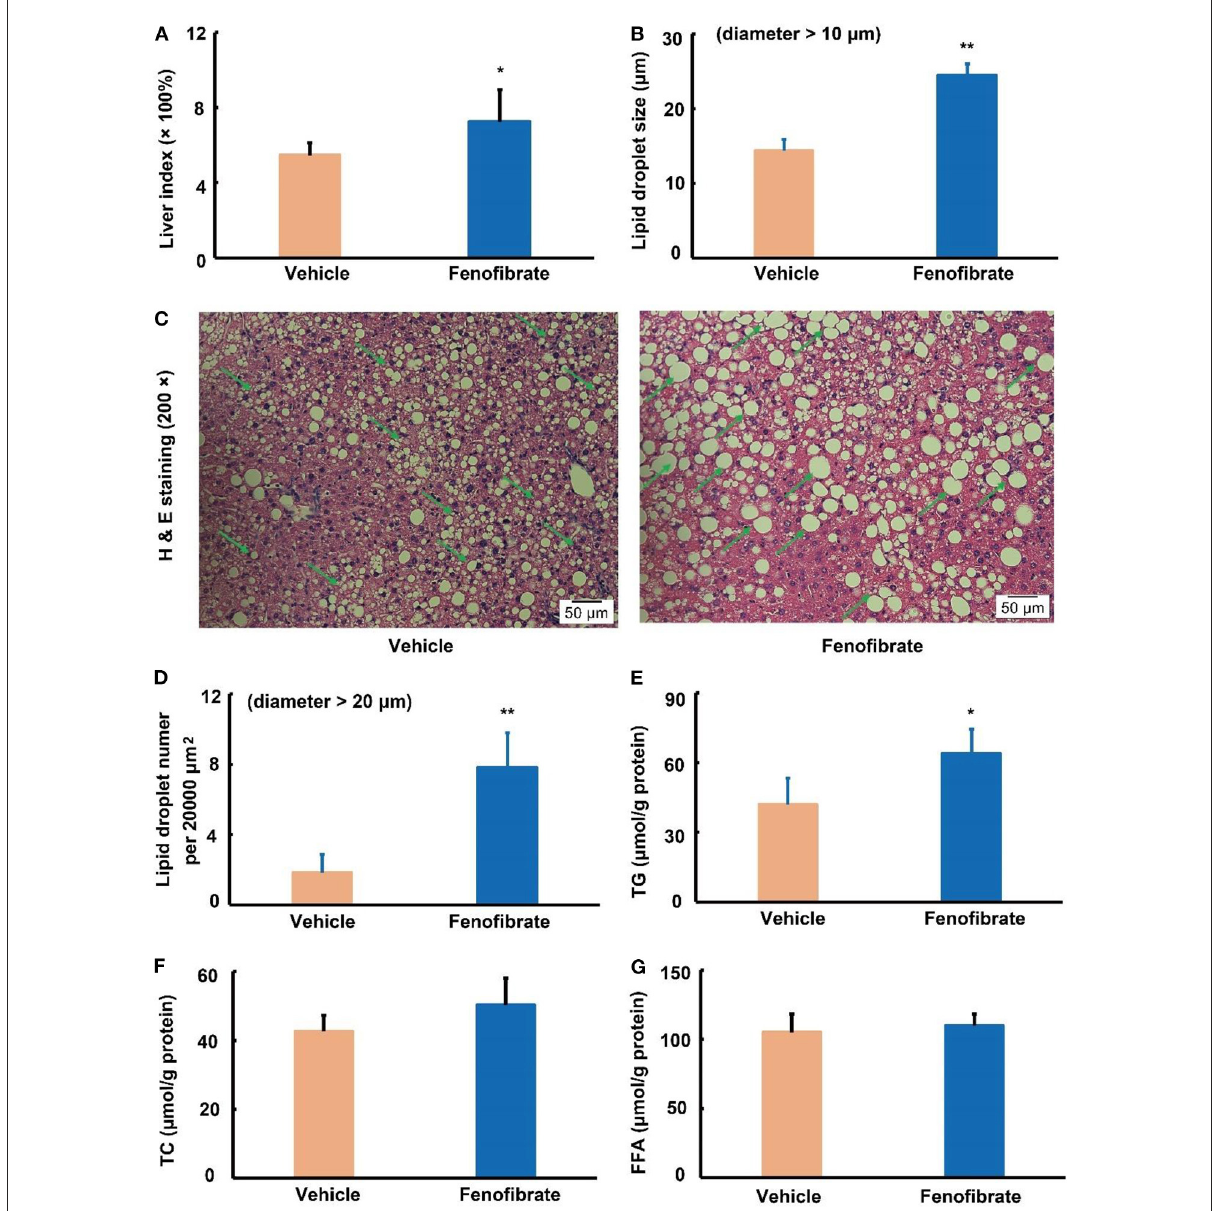
FIGURE2 Effect of fenofibrate on the liver index, lipid droplet formation, and lipid contents in the liver of the ob/ob mice ( n = 7 for the Vehicle group and n = 8 for the fenofibrate group unless otherwise specified). (A) liver index was calculated according to the following formula: liver index = [(liver weight × 100%) ÷ body weight]; (B) the average lipid droplet size, the lipid droplets with a diameter > 10 µ m were used for this statistical analysis in five distinct areas; (C) the typical images of H and E staining ( n = 5); (D) the average number of the lipid droplet with a diameter > 20 µ m per 20,000 µ m 2 ; (E) triglyceride (TG) content of the liver; (F) total cholesterol (TC) content of the liver; (G) free fatty acid (FFA) content of the liver. Data were expressed as mean ± SD, and the statistical analysis was performed by Student- t -test. * means significantly different at p < 0.05 vs. Vehicle group; ** means significantly different at p < 0.01 vs. Vehicle group. Some typical lipid droplets were pointed out using green arrows. Vehicle: mice were treated with 0.5mL of water by gavage for 13 weeks; Fenofibrate: mice were treated with 0.5mL of fenofibrate suspension liquid at the dose of 20 mg/kg/d by gavage for 13 weeks.